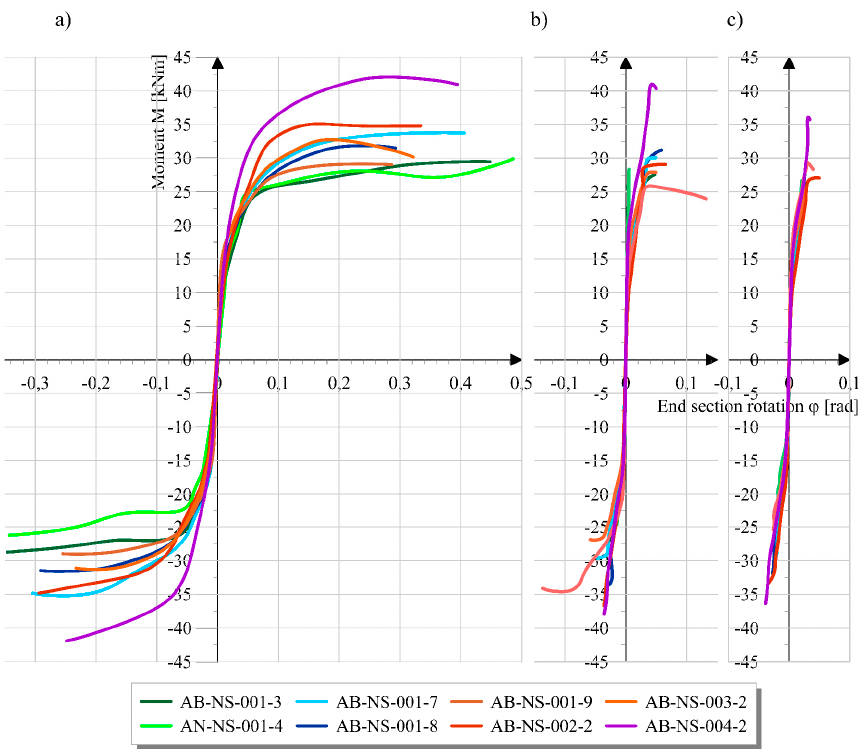
Figure 13. Moment to section rotation ratio of cyclically tested specimens: ( a ) end section; ( b ) 150 mm higher section; ( c ) 350 mm higher section.